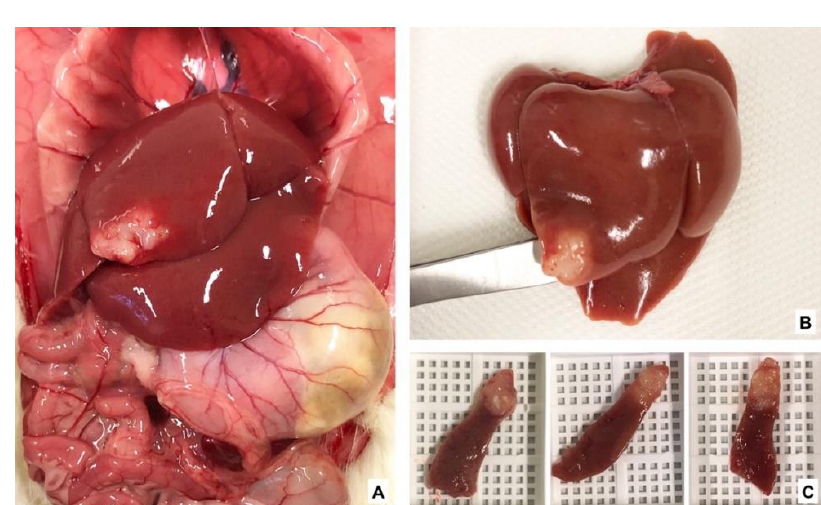
Figure 3. Colorectal cancer liver metastasis and samples for immunohistochemistry. ( A ) Abdominal cavity showing the liver and the implanted tumor; ( B ) Tumor in the median liver lobe; ( C ) Tumor samples for